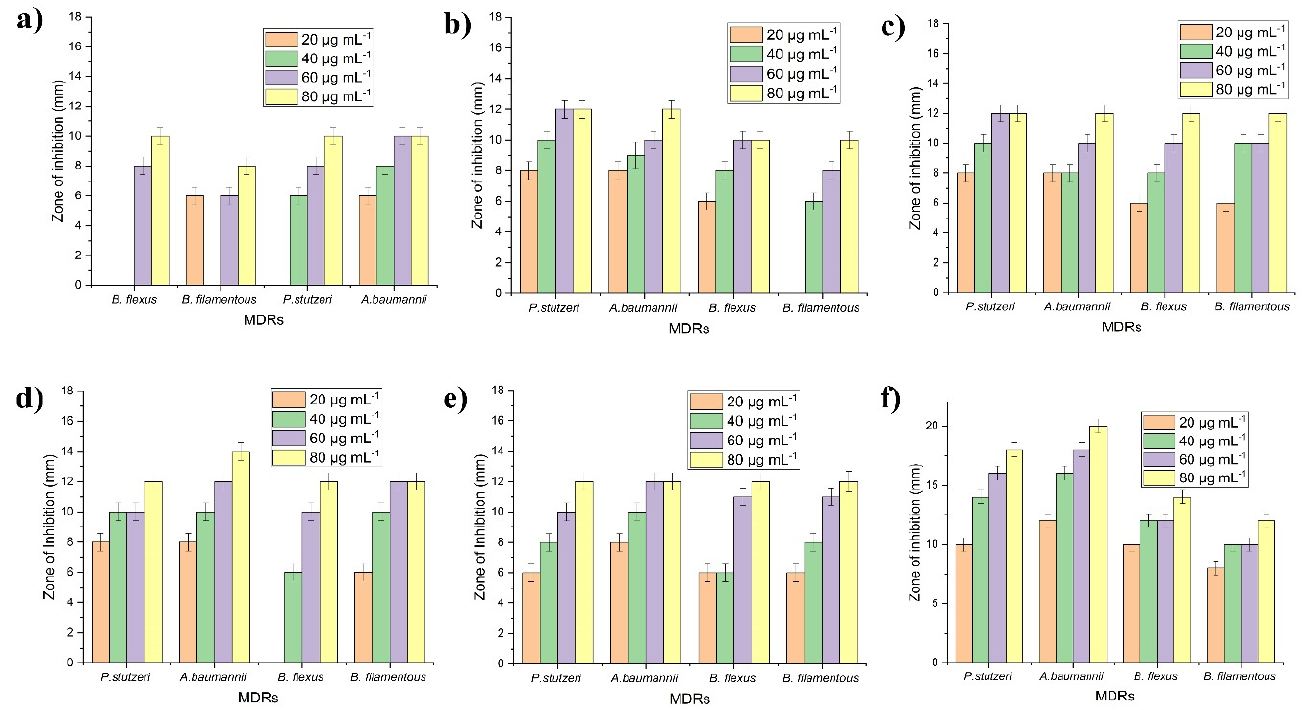
Figure 2. In vitro antibacterial efficacy against 16S rDNA-identified MDRs of NPs and NCs with different concentrations (20, 40, 60, and 80 µ g mL − 1 ) by the well diffusion method: ( a ) pure BiPO 4 -NPs (NPs-1); ( b ) ZnO-NPs (NPs-2); ( c ) BiPO 4 /ZnO-NCs (B1Z1-300:300; NCs-1); ( d ) BiPO 4 /ZnO-NCs (B2Z1-300:150; NCs-2); ( e ) BiPO 4 /ZnO-NCs (B4Z1-300:75; NCs-3); ( f ) BiPO 4 /ZnO-NCs (B1Z4- 75:300;